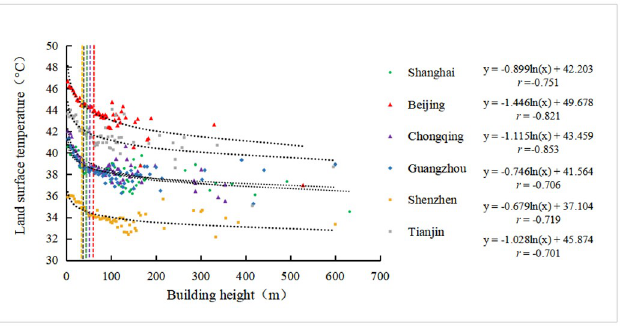
Fig 6. Regression analysis of building height and land surface